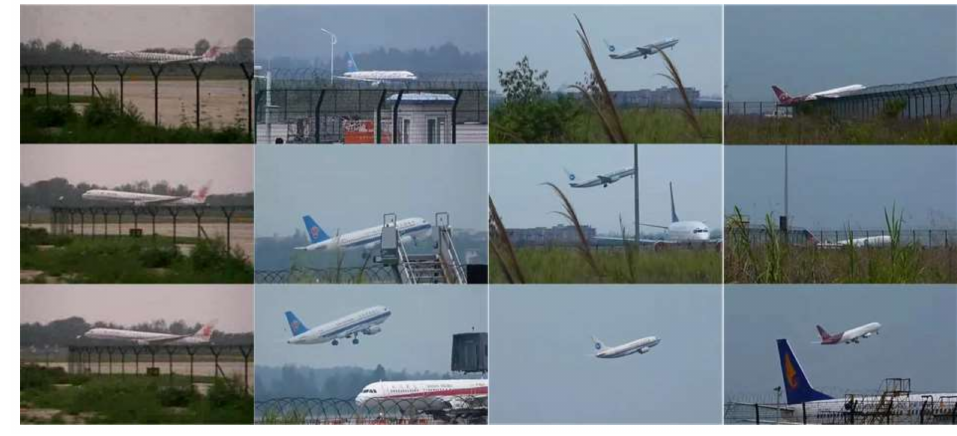
Figure 7. Examples from our moving aircraft database, the aircrafts appear in different scenes.